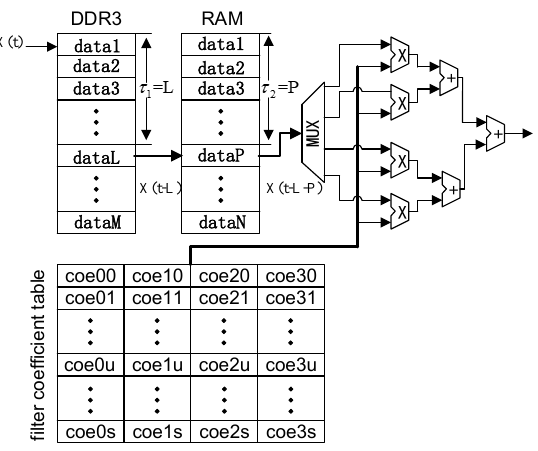
Figure 3. The implementation scheme of delay module.